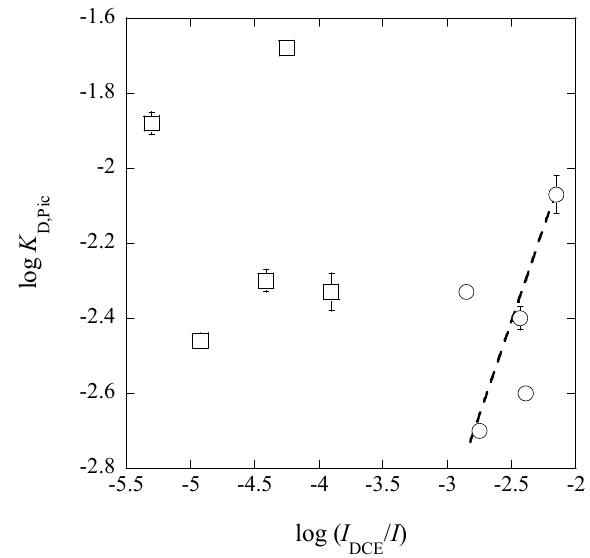
Figure 9. A plot of log K D,Pic vs. log( I DCE / I ) for the AgPic extraction with B18C6 into DCE. The broken line shows a theoretical one for the slope fixed at unity: see the text. The plots (square) were of the extraction with the excess addition of HNO 3 in the w phases.